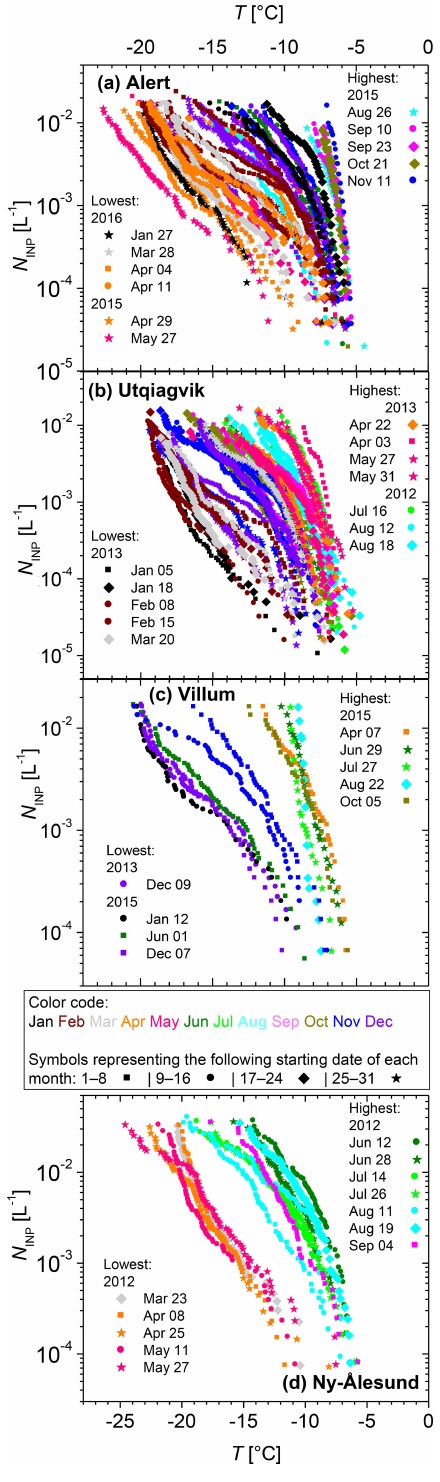
Figure 2. N INP for all samples. Symbol color distinguishes between data obtained for the different months, while symbol type indicates the day of the month when sampling started. Curves with particu- larly high and low N INP are explicitly listed in the legend. (The T axis is the same for panels a – c and different for panel d ; see values for T given on the top and bottom of the figure, respectively.)